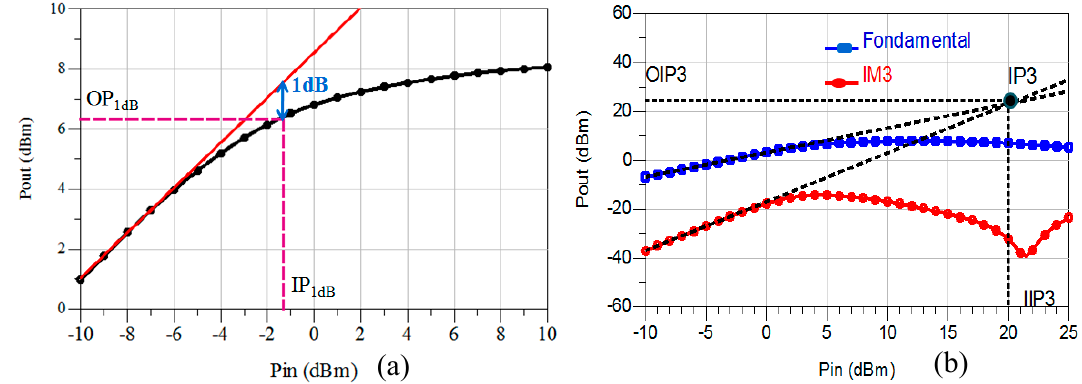
Figure 6. Simulated results of: ( a ) isolation , and ( b ) Simulated results of power gain and noise figure (NF).